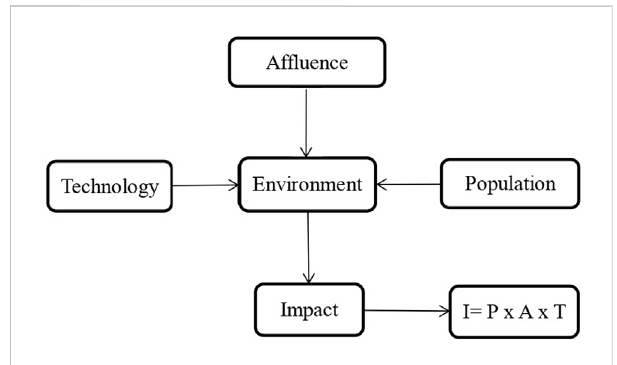
FIGURE 2 Human population impacts on the